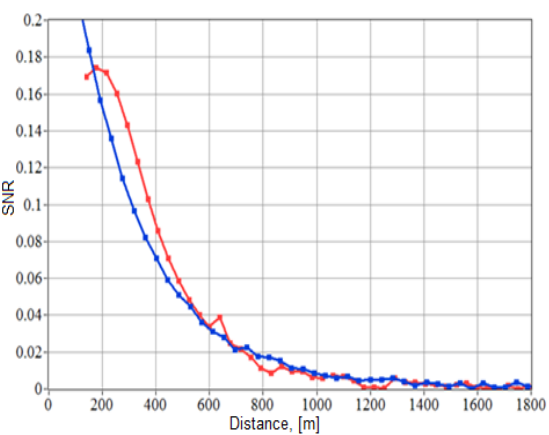
Fig.5. SNR measured by Stream Line lidar (blue line) and by IAO-lidar (red line) 04.02.2019.